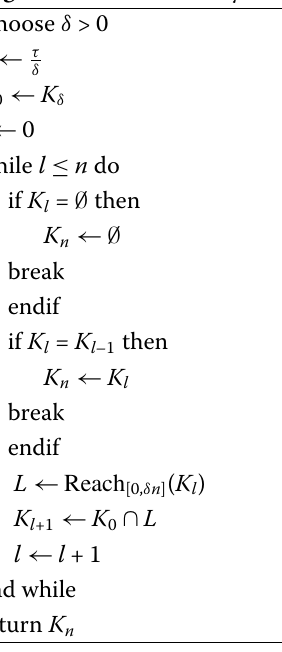
Algorithm 3 The viability kernel of continuous-time switched